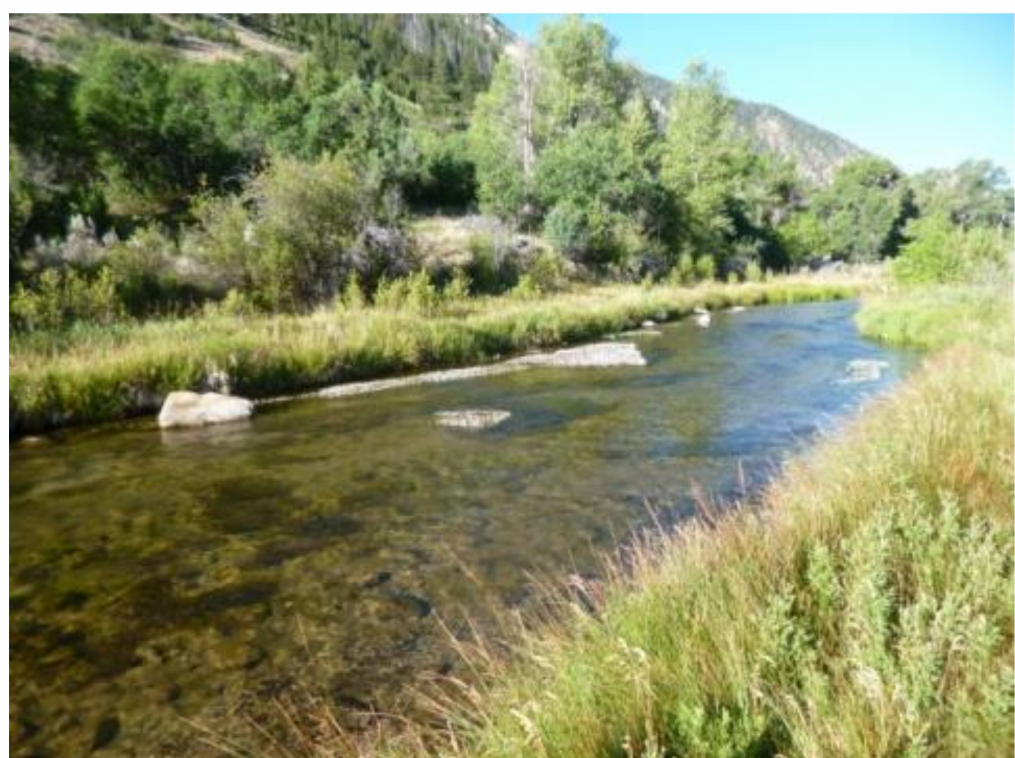
Figure 5. A paradisiac site for fly fishing may be found even downstream of a dam. The Strawberry river (Uinta region, UT, USA; photo: Andrea Nardini) downstream of the homonymous artificial reservoir is indeed, from personal experience, a magnificent stream for fly fishing. Beyond the beautiful scenery, this is linked precisely to the presence of the dam: in summer, flow rates are increased (hence offering more habitat to fish populations than in natural conditions); excessive frequent floods are smoothed, hence ensuring less stress; water is cooler (because extracted from the reservoir bottom), sufficiently oxygenated and clearer (thanks to settlement of fine solids within the reservoir), so allowing a deeper penetration of solar light and, with that, a likely higher ecosystem productivity, beneficial to a consistent brown trout population. At the same time, the nutrient balance does not appear to have been significantly altered (in spite of the natural supply of phosphorous loads from its upstream basin and possibly thanks to restoration programs; see, for instance: https://extension. usu.edu/waterquality/files-ou/Watershed-information/Main/NR_WQ_2014-02StrawberryRiver.pdf, accessed on 8 May 2021), and the geomorphic impact is reduced, probably because both the sediment supply and the transport capacity have been reduced, in this way keeping a certain equilibrium [43]. This fortunate combination does not hold, however, for other rivers in the region, for instance the Duchesne river, significantly altered as shown by [44]. Notice that we do not claim that this quite odd situation be of general validity and notice, moreover, that we are not focusing on native species, which may be affected quite negatively (as demonstrated in other situations, for instance by [45]), but rather on a (non-native) species of great interest for sport fishing: brown